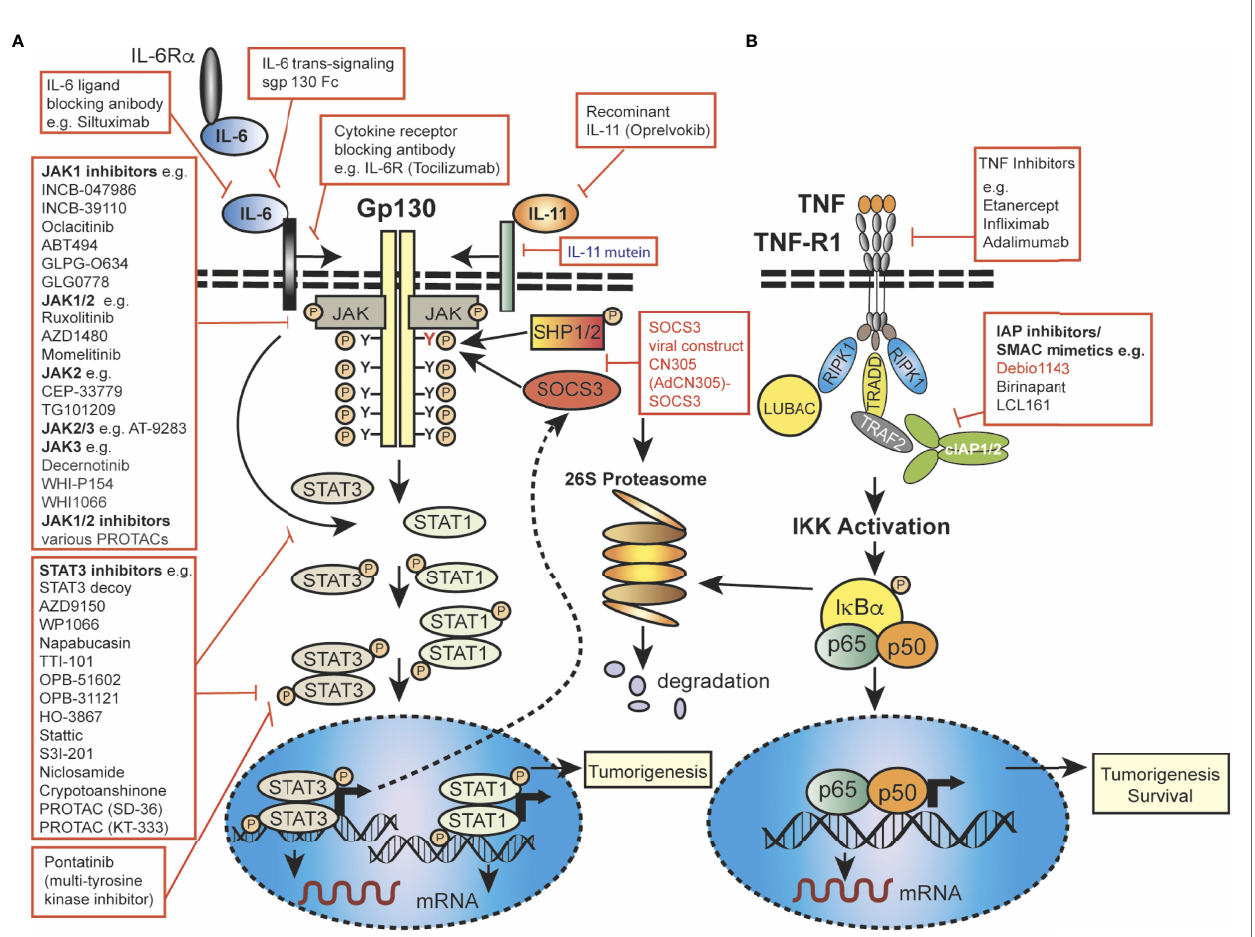
FIGURE 2 | Mechanistic diagram of JAK-STAT and TNFR signalling and modes of inhibition. (A) The gp130 receptor complex and signaling pathways for IL-6 and IL-11 are shown as key activators of STAT transcription factors. The intracellular domain of the gp130 receptor contains a membrane-proximal tyrosine (Y; red), which provides a docking site for the suppressor for SOCSs proteins (e.g. SOCS3) and SHP2, while the membrane-distal tyrosine (Y) sites permits interactions with the SH2 domain of STAT1/3. The membrane proximal Y sites are phosphorylated by JAKs and upon phosphorylation of the distal Y site, STAT1 and STAT3 are recruited, homo-dimerise and are translocated into the nucleus, where they bind to speci fi c target genes to regulate their expression. (B) Simpli fi ed schematic diagram of TNF/TNFR1 signaling pathway with downstream interacting proteins indicated. (A, B) Red arrows indicate intervention/ inhibition points within each pathway and red boxes list examples of JAK-STAT or cytokine inhibitors/modifying drugs with their target